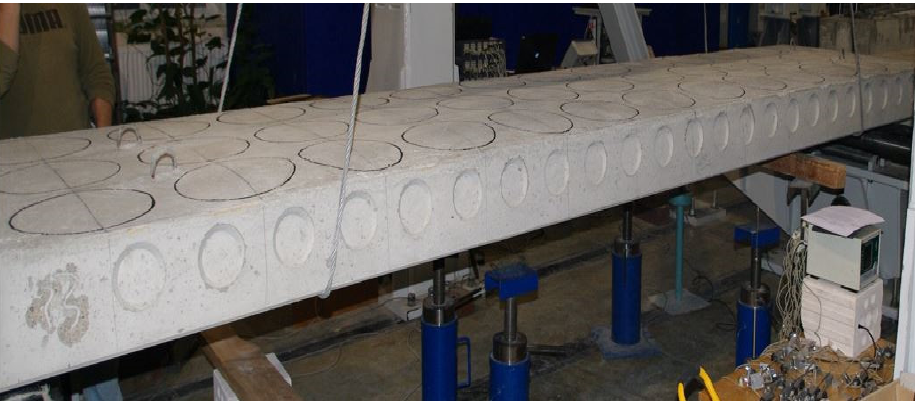
Figure 3. Overall view of the manufactured slab.